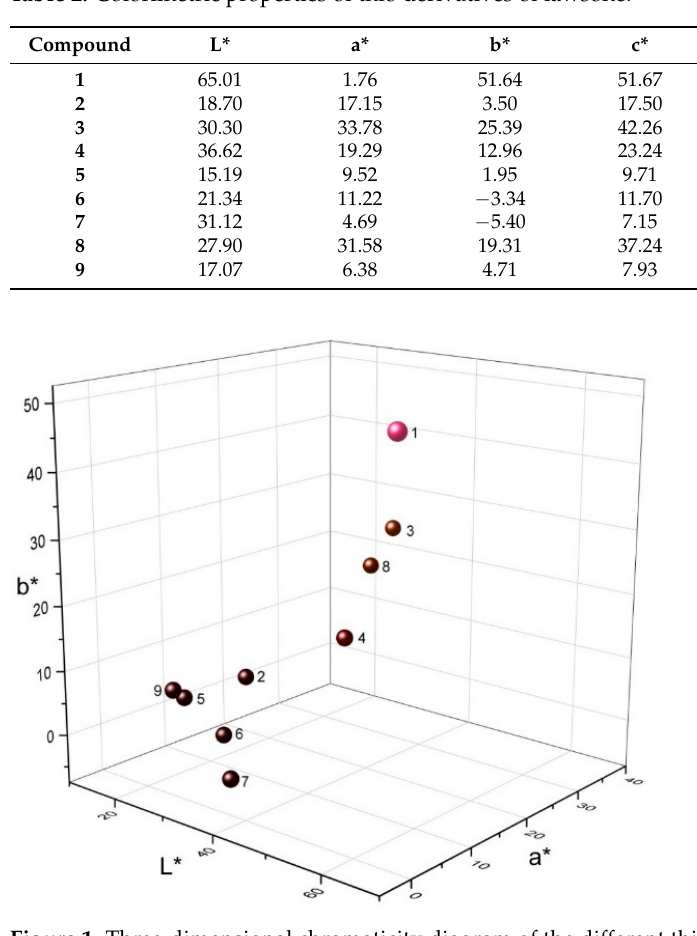
Figure 1. Three-dimensional chromaticity diagram of the different thio-lawsone